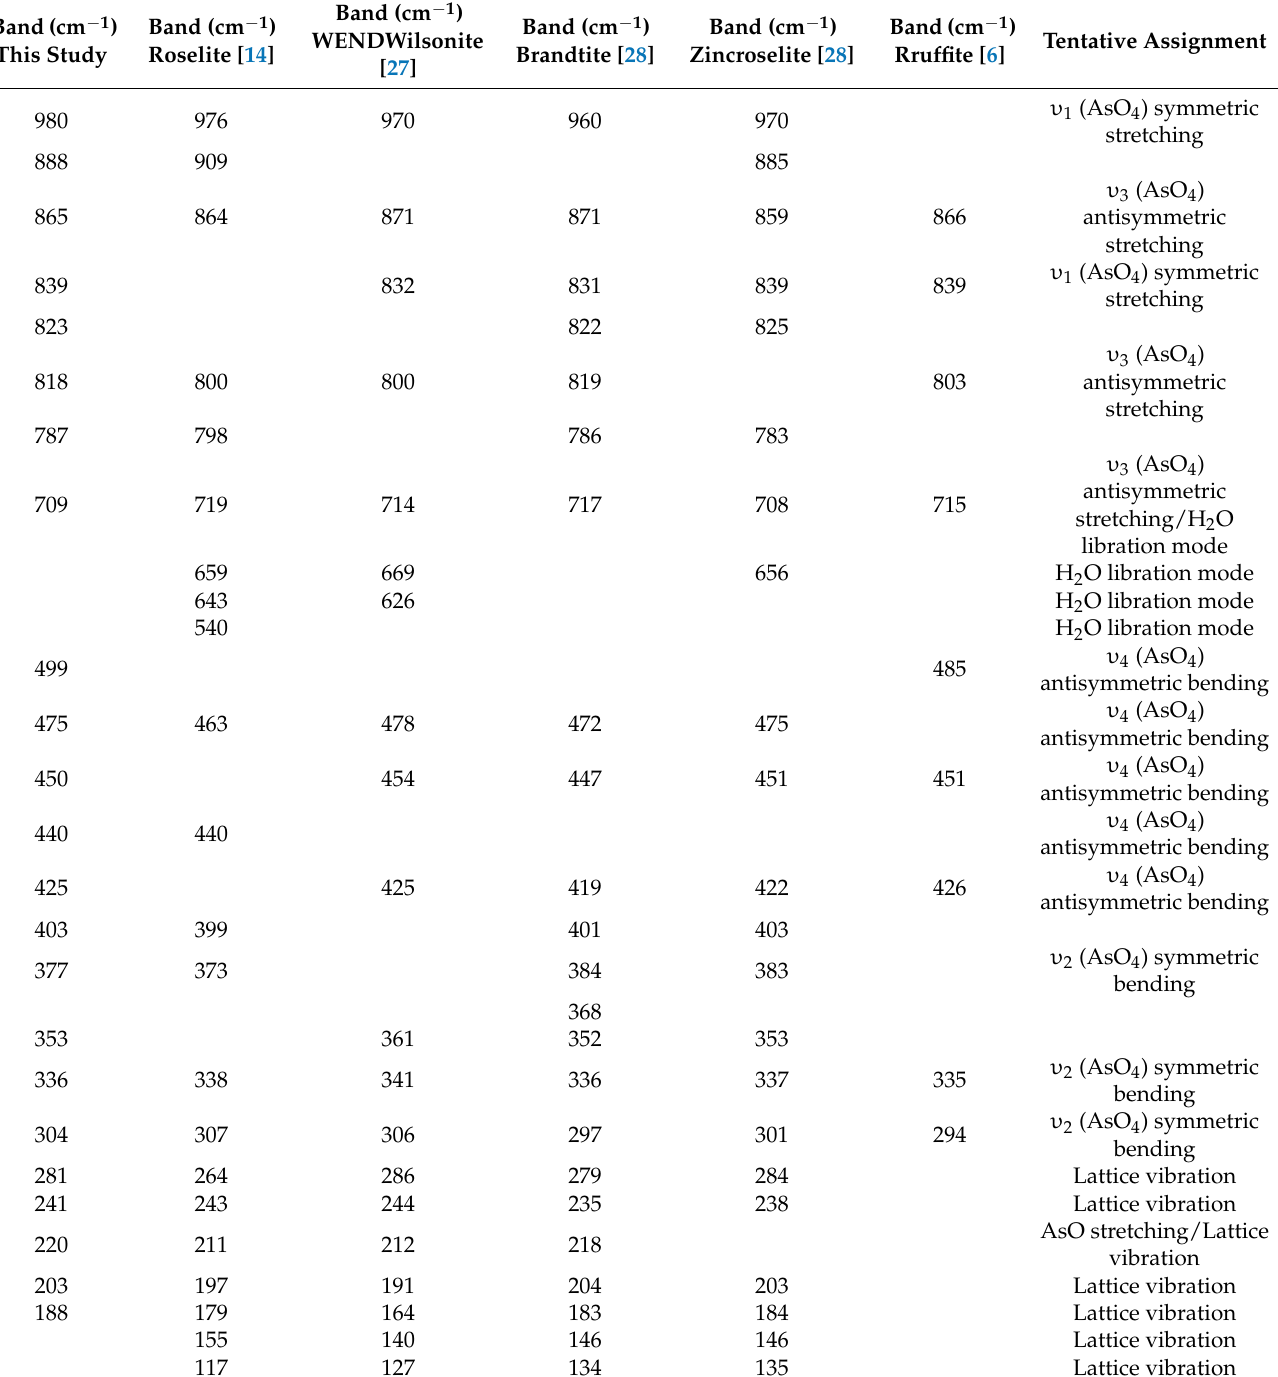
Table 2. Tentative assignment of the observed roselite Raman bands in comparison to the other minerals of the roselite